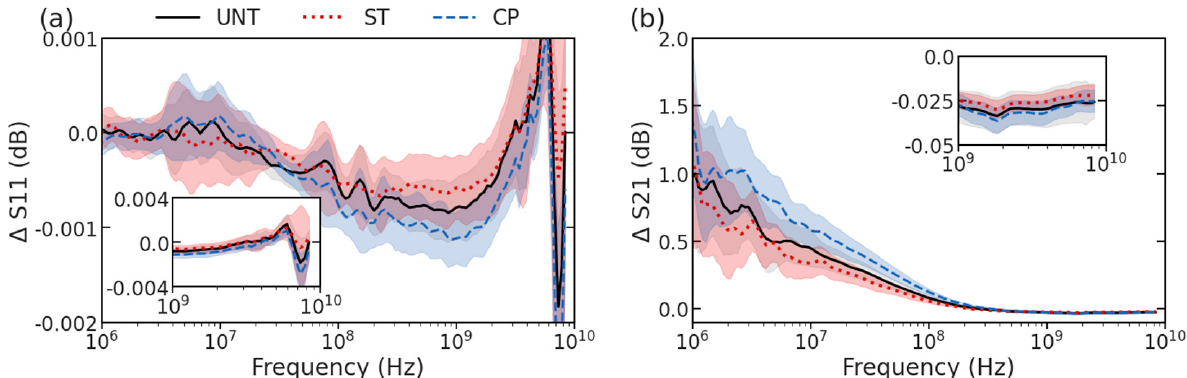
Figure 3. Swept spectra showing mean (lines) and standard deviation (shadows) for ( a ) Δ S11 and ( b ) Δ S21. UNT cells are shown using black with a gray shadow, ST − treated cells are shown using red line and shadow, and CP − treated cells are shown using a blue line and shadow.